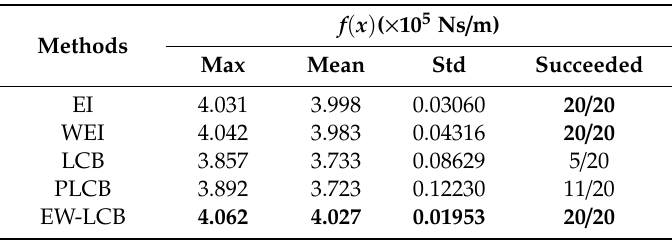
Table 9. The statistical optimization results of the engineering case with di ff erent